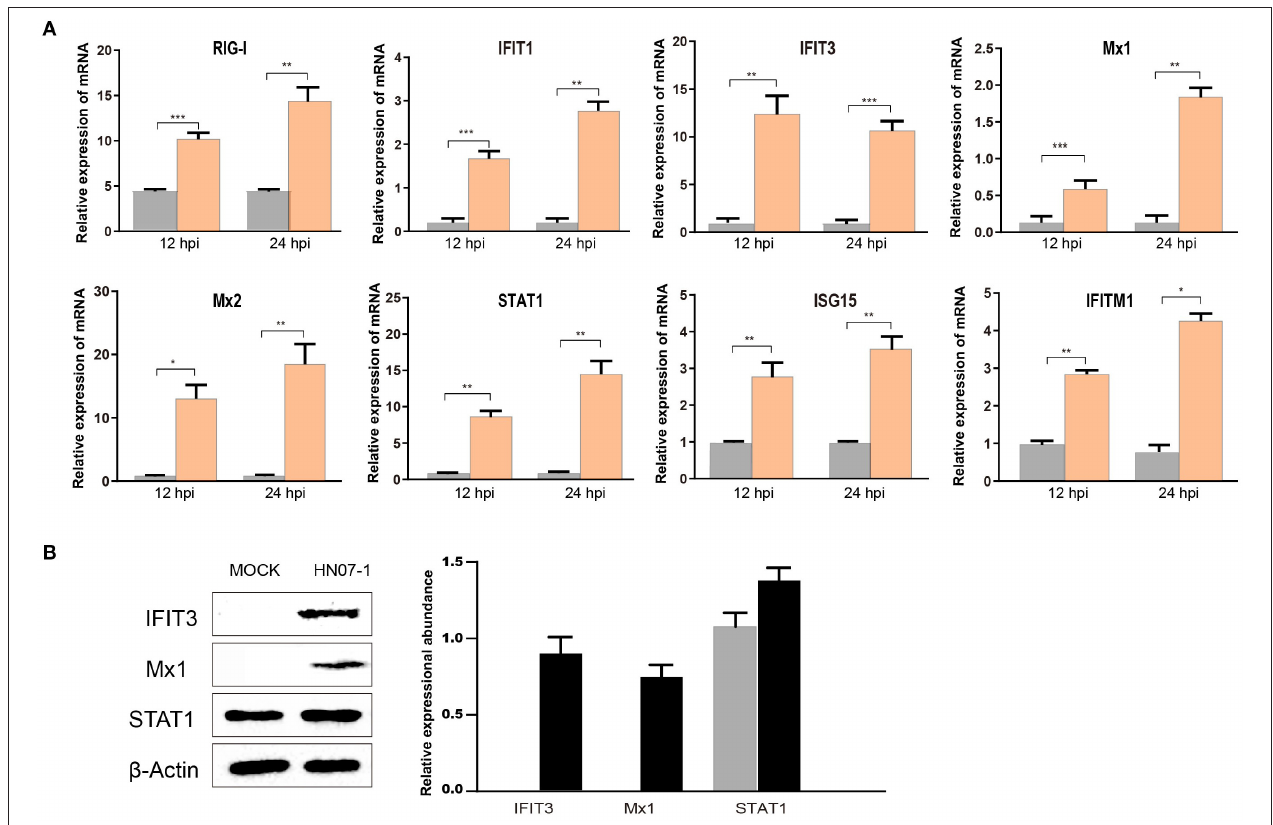
FIGURE 5 | Confirmation of up-regulated proteins using RT-PCR and WB analyses. (A) PAMs were infected with HP-PRRSV HN07-1 at MOI = 0.1 or mock-infected. Samples were collected at 24 hpi for RT-PCR detection for analysis of relative mRNA abundances of RIG-I, IFIT1, IFIT3, Mx1, Mx2, ISG15, STAT1, and IFITM1. (B) PAMs were infected with HP-PRRSV at MOI = 0.1 or mock-infected. Samples were collected at 24 hpi for WB to analyze protein expression levels of STAT1, IFIT3, Mx1, and β -Actin. * P < 0.05; ** P < 0.01; *** P < 0.001; ns, not